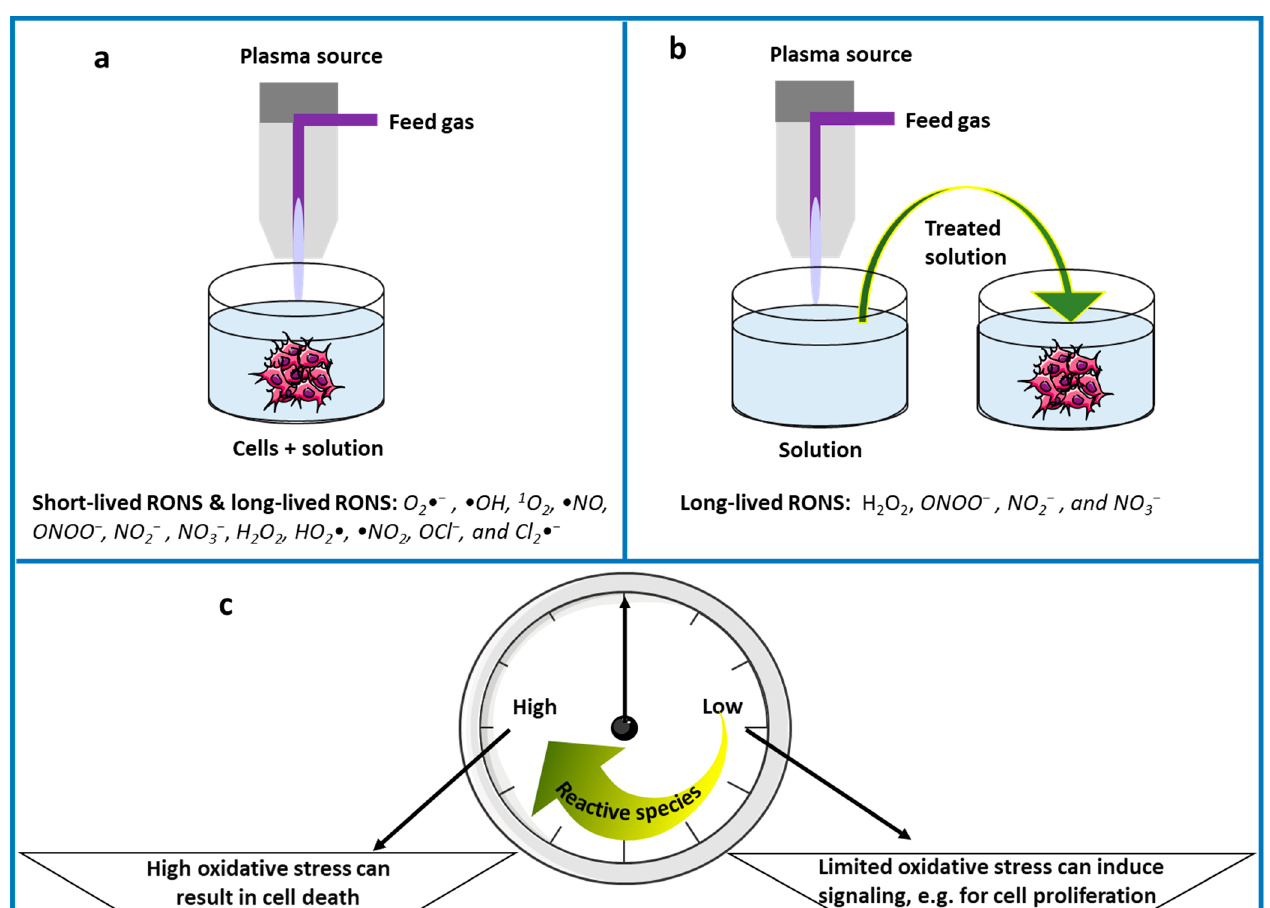
Figure 1. Schematic illustration for the use of CAP in ( a ) direct treatment and ( b ) indirect treatment, indicating also the typical “products” of both strategies, i.e., both short-lived and long-lived RONS in ( a ) and only long-lived RONS in ( b ). ( c ) shows that low levels of reactive species play an important role in cell signaling for various biological processes, such as cell proliferation, whereas high levels can induce cell death. Note that ( a , b ) can both give rise to high and low RONS levels, and thus to cell death and cell proliferation.